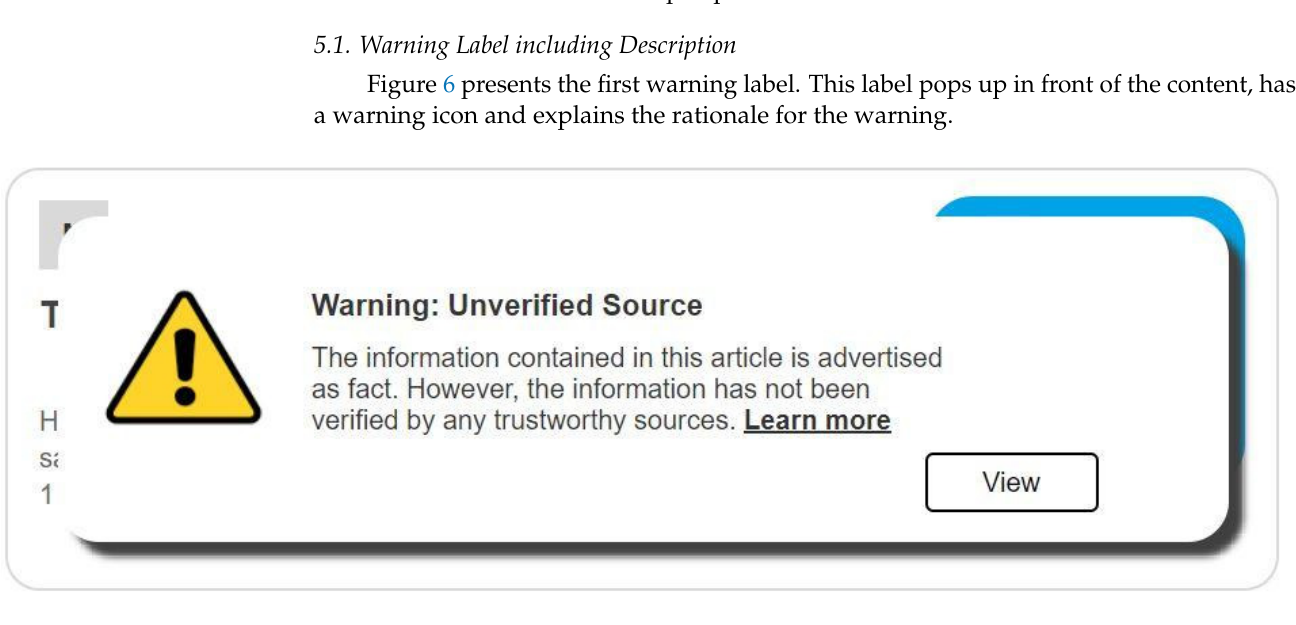
Figure 6. Warning label with description [76].